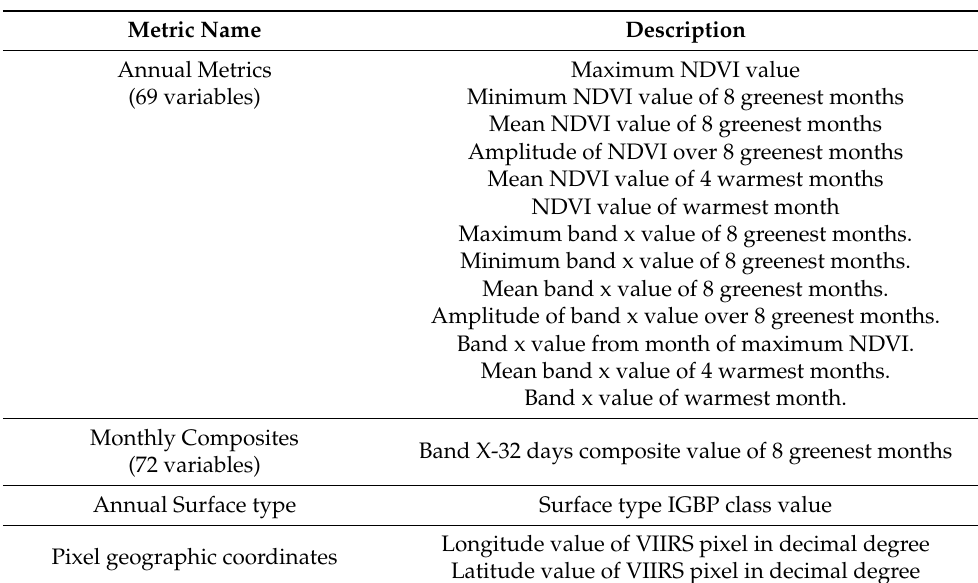
Table 1. Multi-temporal metrics used to produce wall-to-wall maps of tree canopy structure. Band x refers to each of the 9 composited M-Bands (M1-M5, M7, M8, M10, and